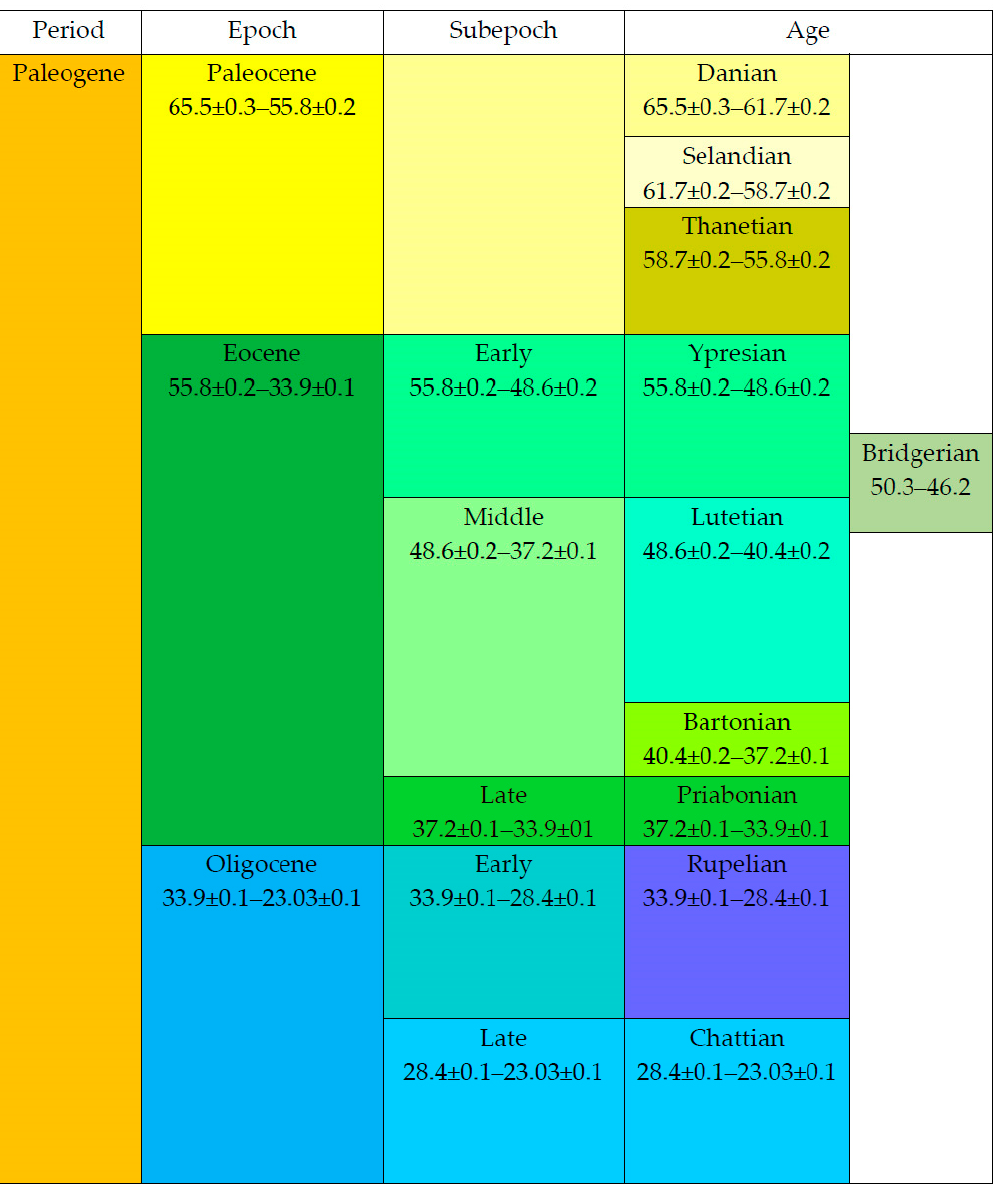
Table 1. Localities with Curculionoidea from the Paleogene.